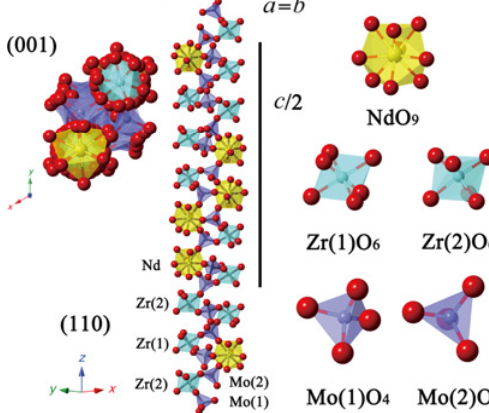
Fig. 3 Refined crystal structures of NZ 1 − x T x M ( x = 0.02–0.10)